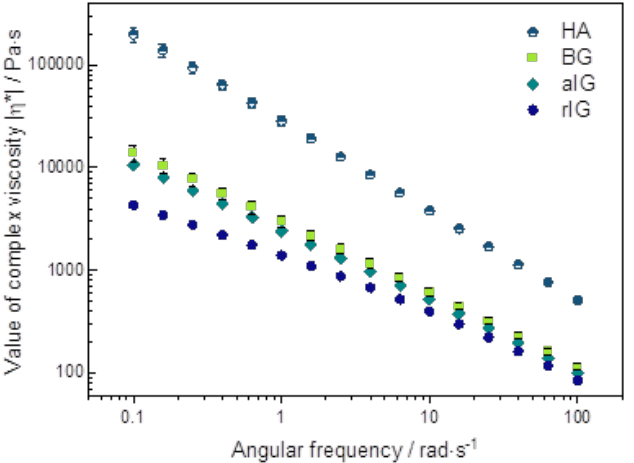
Figure 5. Values of complex viscosities of alginate composite inks in direct comparison of round and angular filler particles incorporated into the alginate matrix.